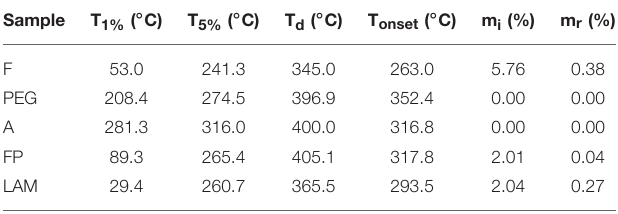
TABLE 3 | Results of the TGA tests on the prepared samples. Sample